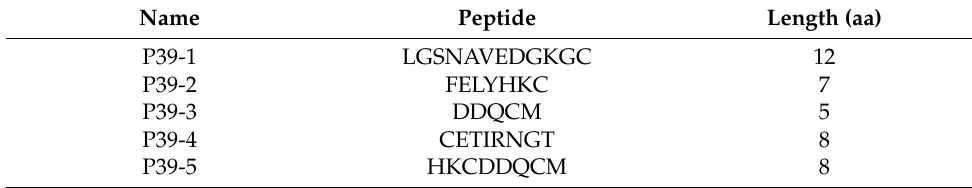
Table 2. Amino acid sequence of truncated